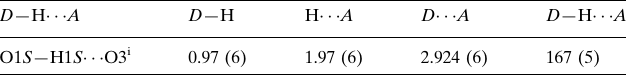
Hydrogen-bond geometry (A ˚ , (cid:5)